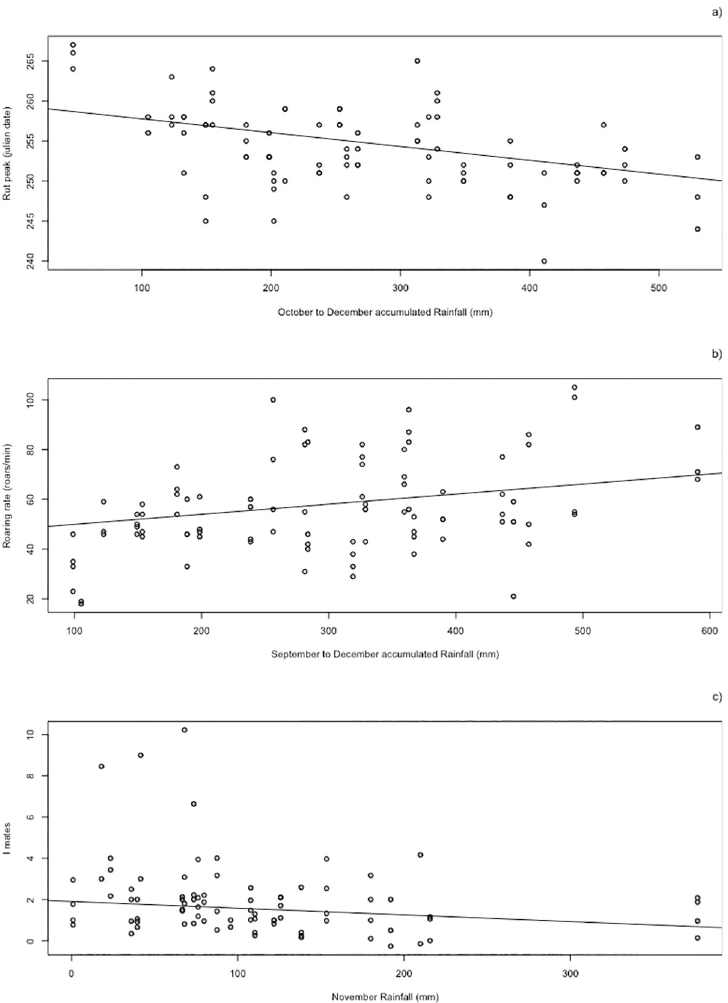
Fig 2. Predictions of the response variables rut peak (a), roaring rate (b) and opportunity for sexual selection (c) against their most relevant rainfall window in millimeters (filled black points and regression line). Raw data are also shown as open